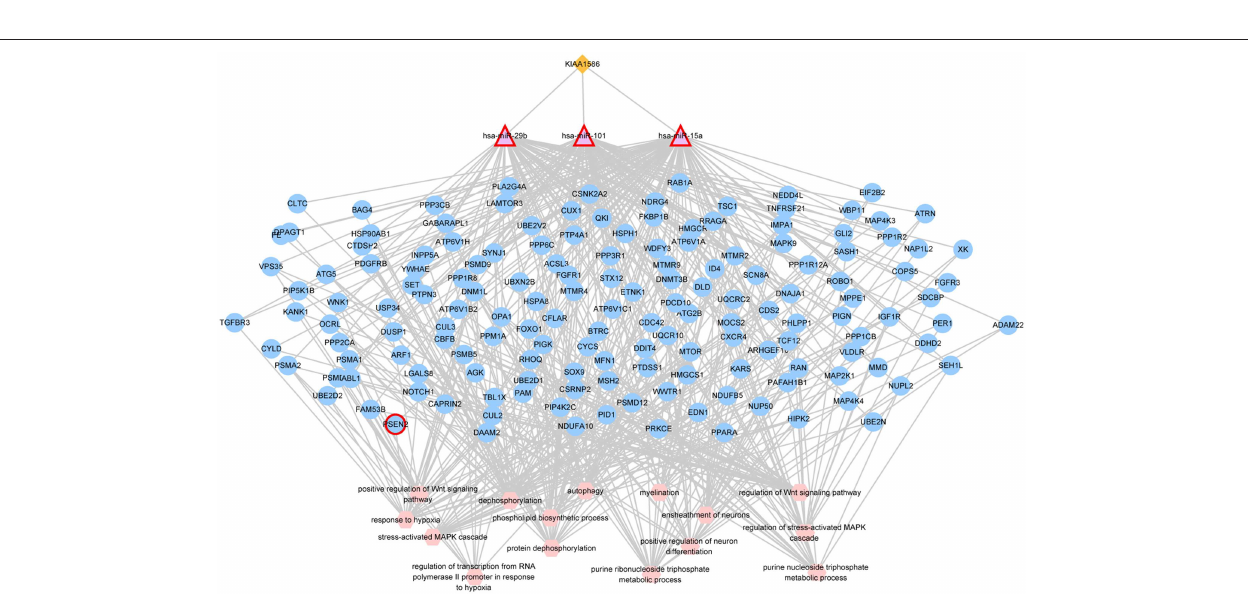
FIGURE 2 | The AD risk circRNA-associated ceRNAs involving in KIAA1586 . The orange diamonds represented circRNAs, purple triangles represented miRNAs, blue circles represented target mRNAs, and pink hexagons represented GO biological functions. The red border represented known AD-related nodes. The edges among circRNAs, miRNAs and mRNAs represented competitive interactions, and the edges between mRNAs and functions represented that the mRNAs were annotated in the GO terms.